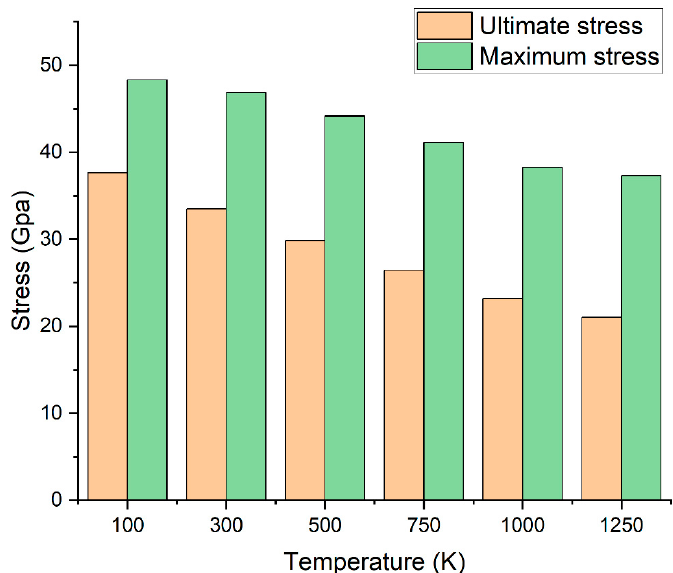
Figure 10. Ultimate stress and maximum stress of PGO at different temperatures.